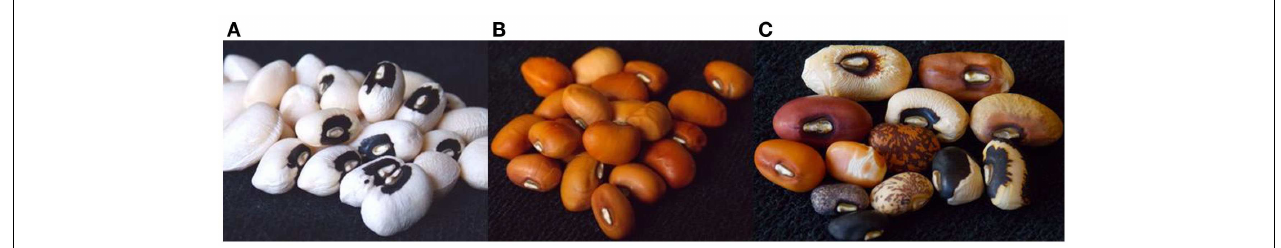
FIGURE 1 | Popular cowpea seed types include “blackeyed” and “buff” represented by (A) California Blackeye 27 and (B) IT82E-18. However, a diversity of cowpea seed types exist (C)